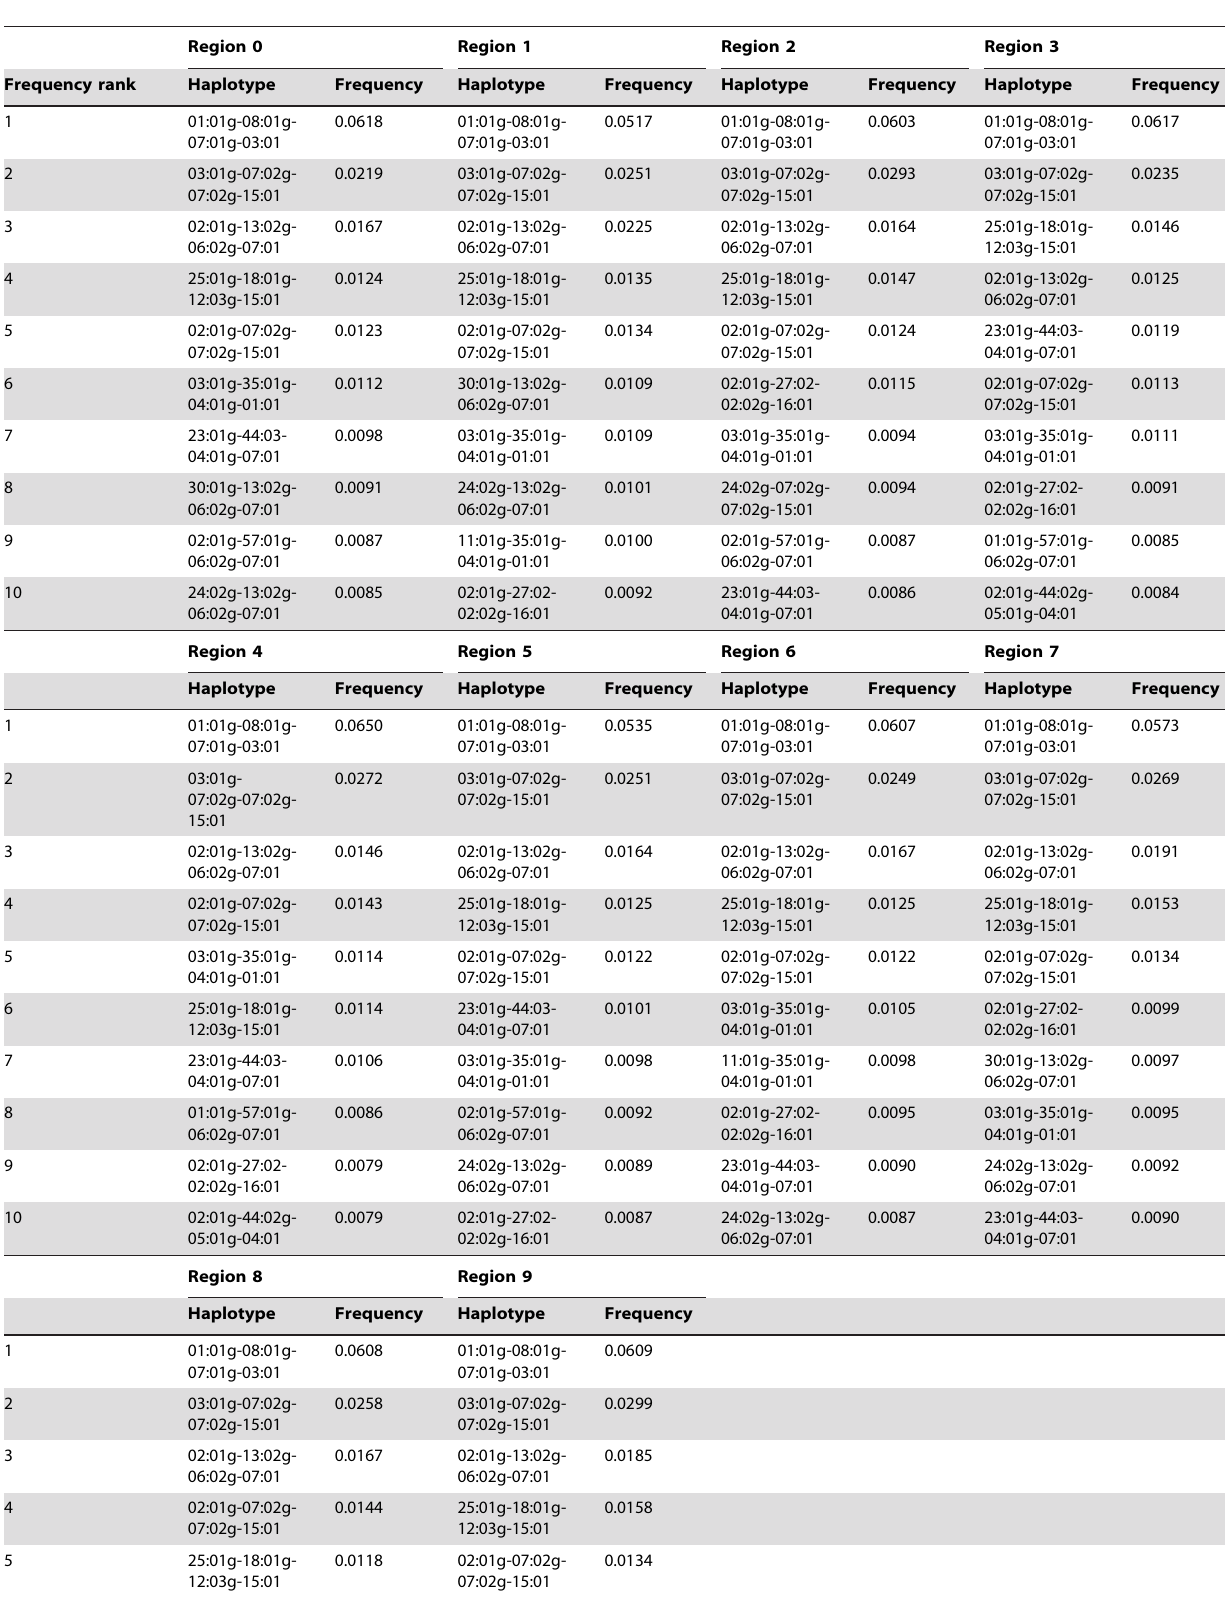
Table 4. 10 most frequent HLA-A, -B, -C, -DRB1 haplotpyes for Polish 1-digit postal code regions